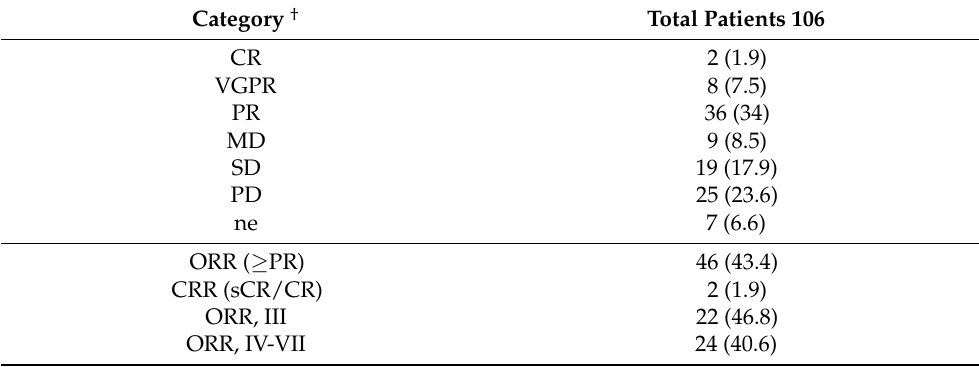
Table 3. Best response to pomalidomide plus dexamethasone